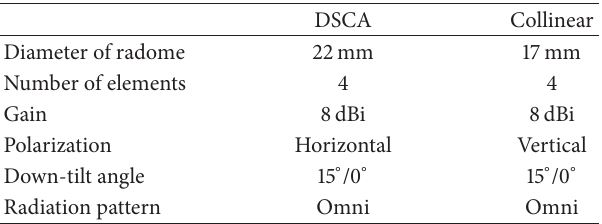
Table 1: Specifications of DSCA prototype and conventional collinear